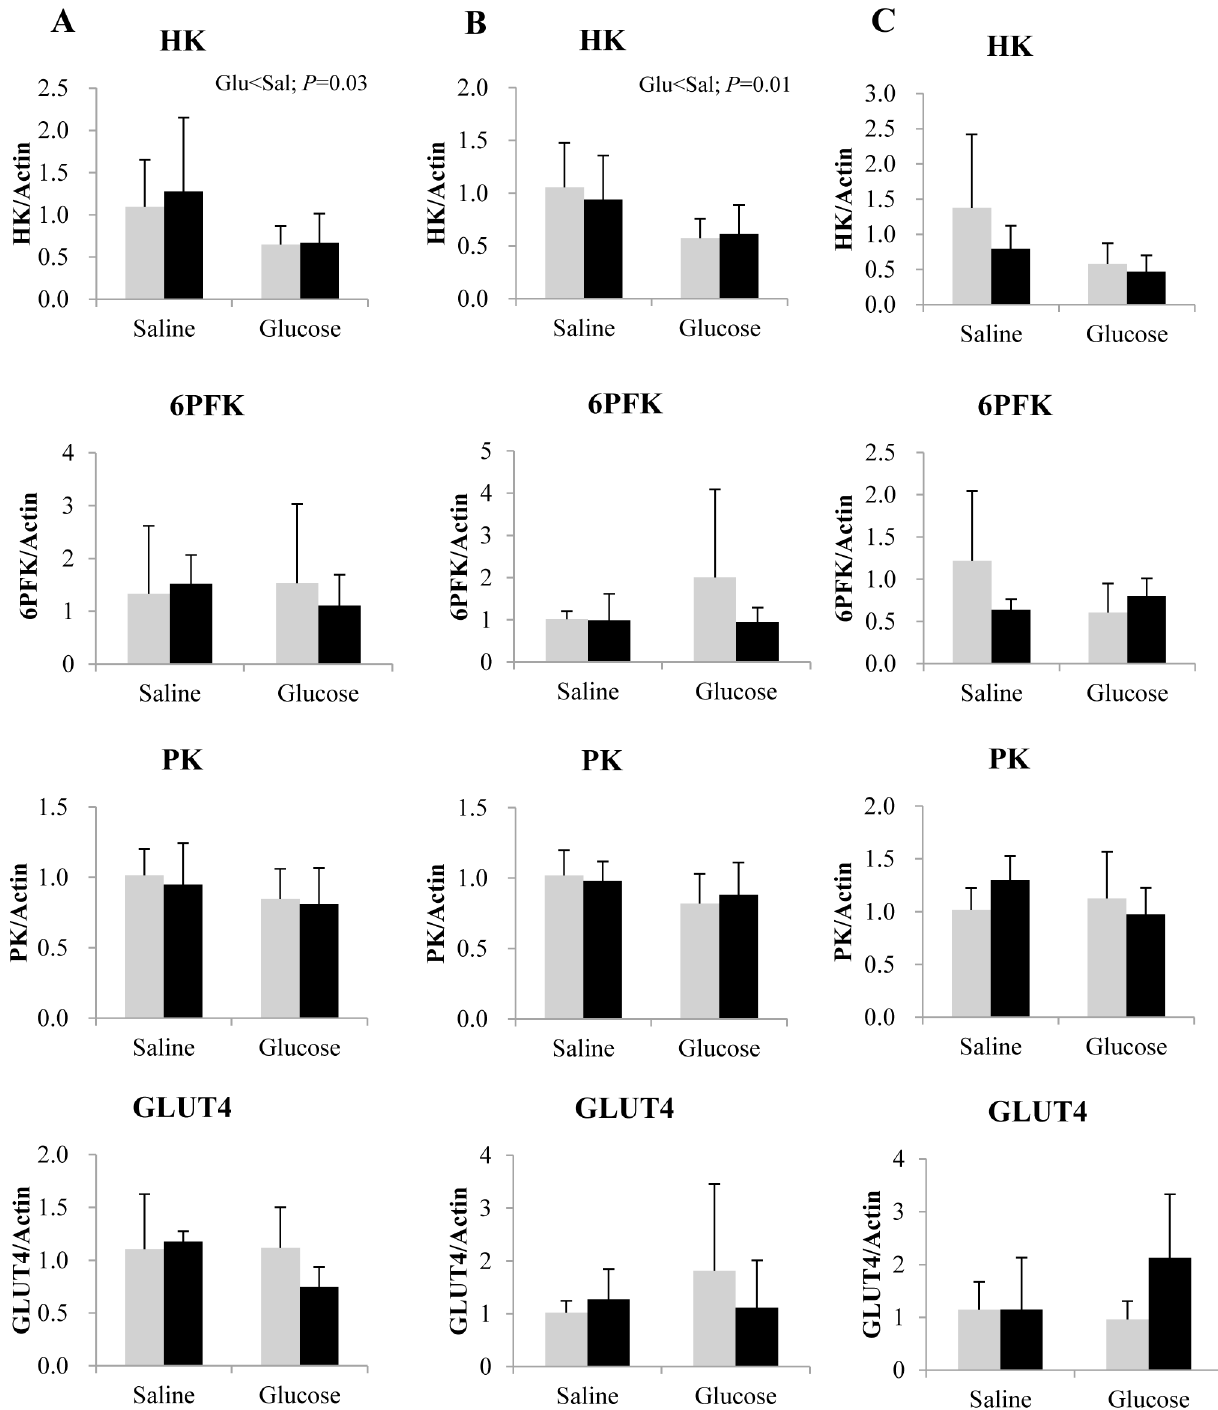
Figure 5. Gene expression of selected glycolytic enzymes and glucose transporter in the muscle of rainbow trout from L line (L; grey bars) and F line (F; black bars) at 3 h (A), 8 h (B) and 12 h (C) after IP administration of glucose or saline solution. Hexokinase (HK), 6-phosphofructo-1-kinase (6PFK), pyruvate kinase (PK) and glucose transporter type 4 (GLUT4) mRNA levels were measured using real-time quantitative RT-PCR. Expression values were normalized by b -actin-transcripts. Results are expressed as means 6 SD ( n =6) and were analyzed using two-way ANOVA ( P , 0.05), followed by a Student-Newman-Keuls multiple comparison test. doi:10.1371/journal.pone.0105548.g005 treatment ( n = 6/line). Plasma glucose (Glucose RTU, bioMe´r- ieux, Marcy l’Etoile, France), triglycerides (PAP 150, bioMe´rieux) Liver and muscle glycogen levels were measured using the and free fatty acids (NEFA C kit, Wako Chemicals, Neuss, amyloglucosidase method [38] on tissues sampled 8 h after